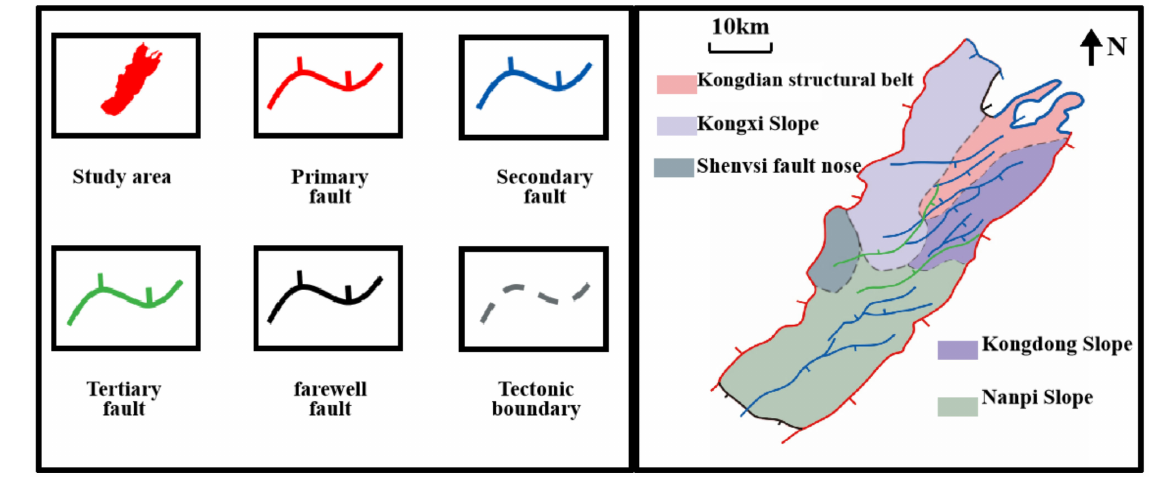
Figure 1. Geographical location and geological structure of Cangdong Sag.